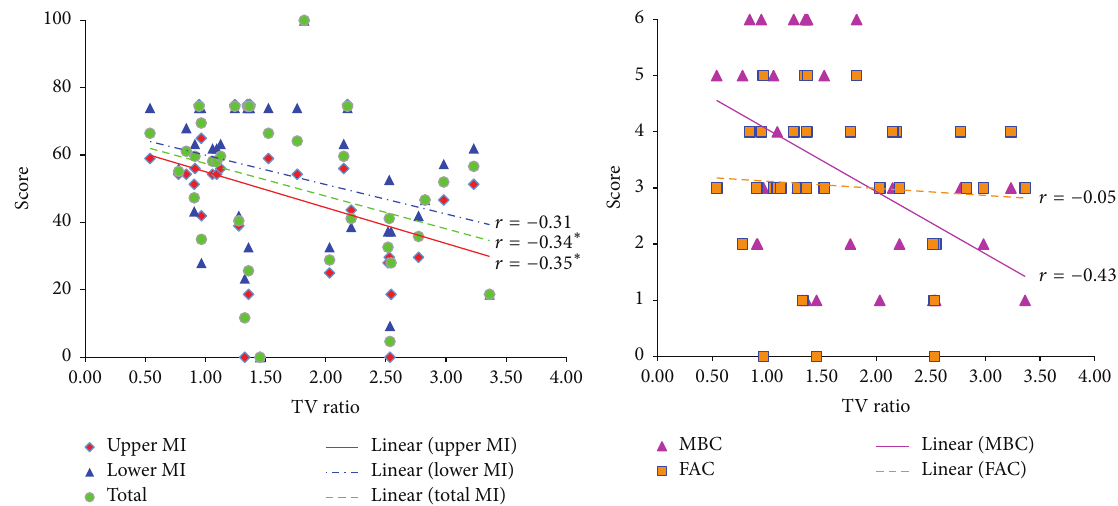
Figure 2: Correlations between motor function and diffusion tensor imaging parameters of connectivity of the red nucleus. MI: Motricity Index, TV: Tract volume, MBC: Modified Brunnstrom Classification, and FAC: Functional Ambulation Category. ∗ 𝑝 < 0 . 05 .